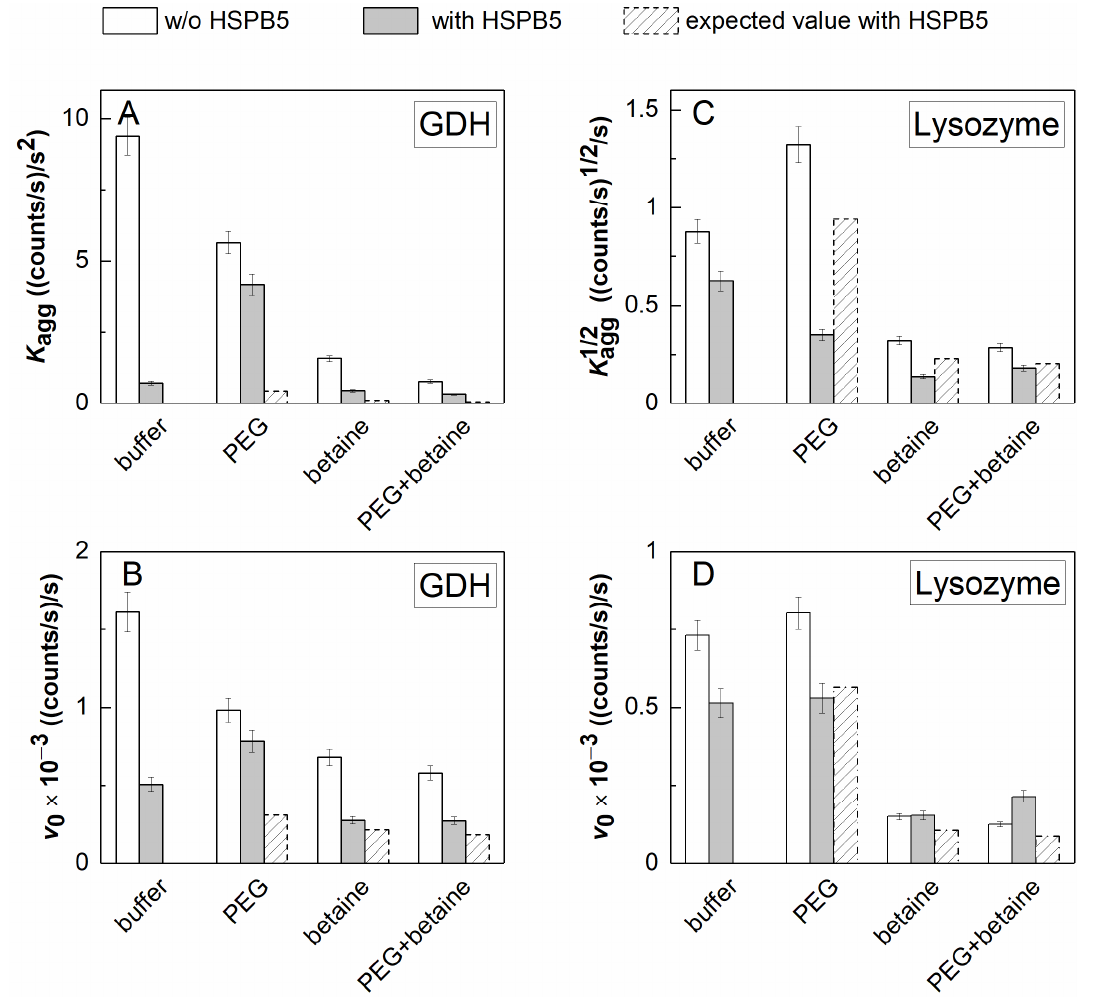
Figure 3. The comparison of HSPB5 effect on the kinetic parameters of the heat-induced aggregation of 0.2 mg/mL GDH at 50 °C and DTT-induced aggregation of 0.15 mg/mL Lyz at 37 °C in the absence and in the presence of 25 mg/mL PEG, 1 M Bet, and their mixture. Bar diagrams of ( A ) K agg values for GDH, ( B ) K agg1/2 values for Lyz, and v 0 values for ( C ) GDH and ( D ) Lyz. The hollow bars correspond to the experimental values for the samples without HSPB5; the gray bars—to the experimental values for the samples with 0.05 mg/mL HSPB5; and the shaded bars—to the expected values if the decrease under the action of HSPB5 is as big as in the buffer.